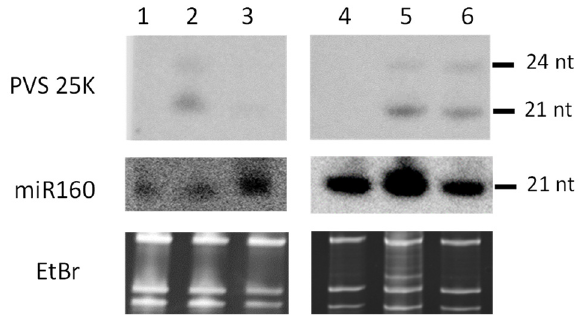
Figure 1. Blot hybridization analysis of sRNAs from transgenic potato lines. Total RNA extracted from leaf tissues of non-transformed potato plants of cultivars Zeren (Lane 1) and Ushkonyr (Lane 4) from the field trials; S-25K-AS transgene-carrying plants of the lines #119 (Lane 2), #61 (Lane 5), and #103 (Lane 6) from the field trials; and an in vitro propagated S-25K-AS transgenic plant of line #119 (Lane 3) was separated on 15% polyacrylamide–urea gel, blotted onto membrane, and UV-crosslinked. The membrane was successively hybridized with 32 P-labled DNA oligonucleotide probes specific to the PVS 25K antisense strand and the plant miRNA miR160 (Dataset S1A). Positions of 21 and 24 nt transgene-derived siRNAs and 21 nt miR160 are indicated. The gel stained with ethidium bromide (EtBr) before blotting is shown as the loading control.